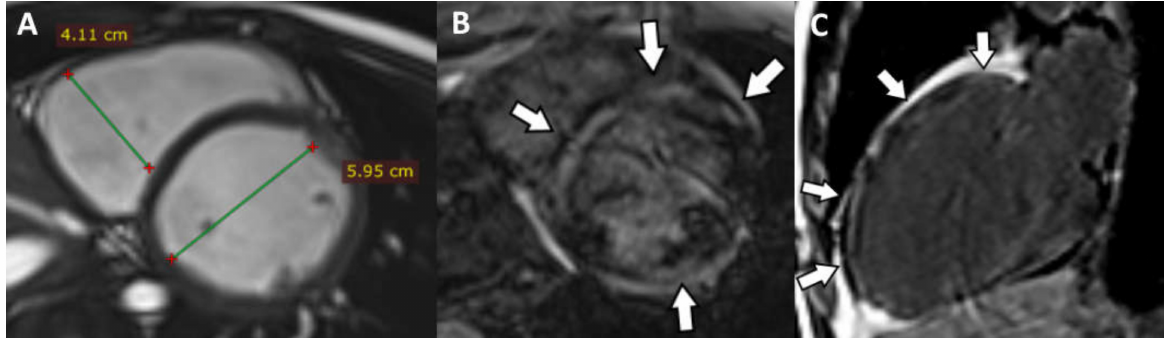
Figure 6. ( A ) Short axis Cine-GRE sequence: basal dilatation of the LV, normal size RV; ( B ) short axis delayed postcontrast PSIR sequence: concentric midmyocardial LGE of LV; ( C ) LV two chambers delayed postcontrast PSIR sequence: non-uniform midmyocardial LGE of the anterior wall of the LV. Cardiac MRI detected enlarged right cavities and dilatation of the LV (RA = 55/49 mm,